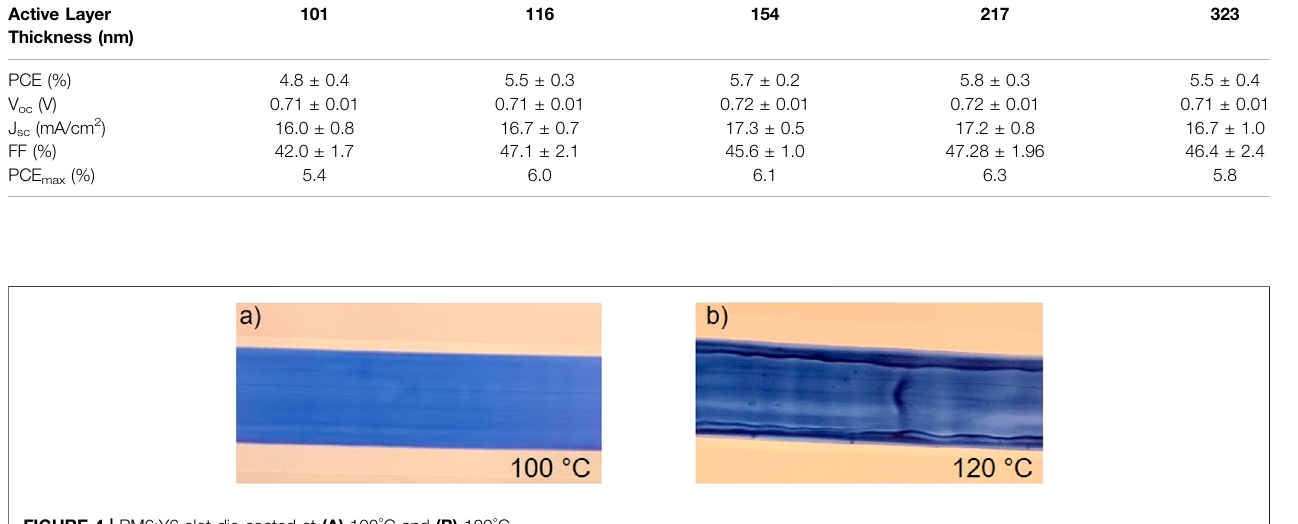
FIGURE 4 | PM6:Y6 slot die coated at (A) 100 ° C and (B) 120 °